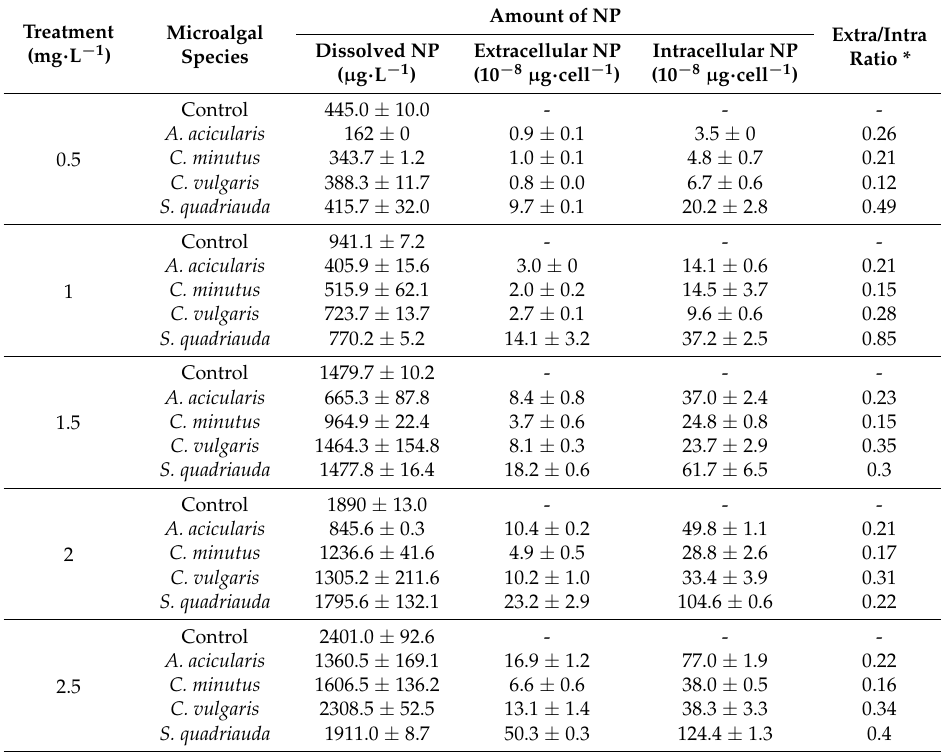
Table 1. Dissolved, intracellular and extracellular NP contents of four freshwater microalgae under different treatments at the end of 24 h. Mean and standard deviation of three replicates are shown.